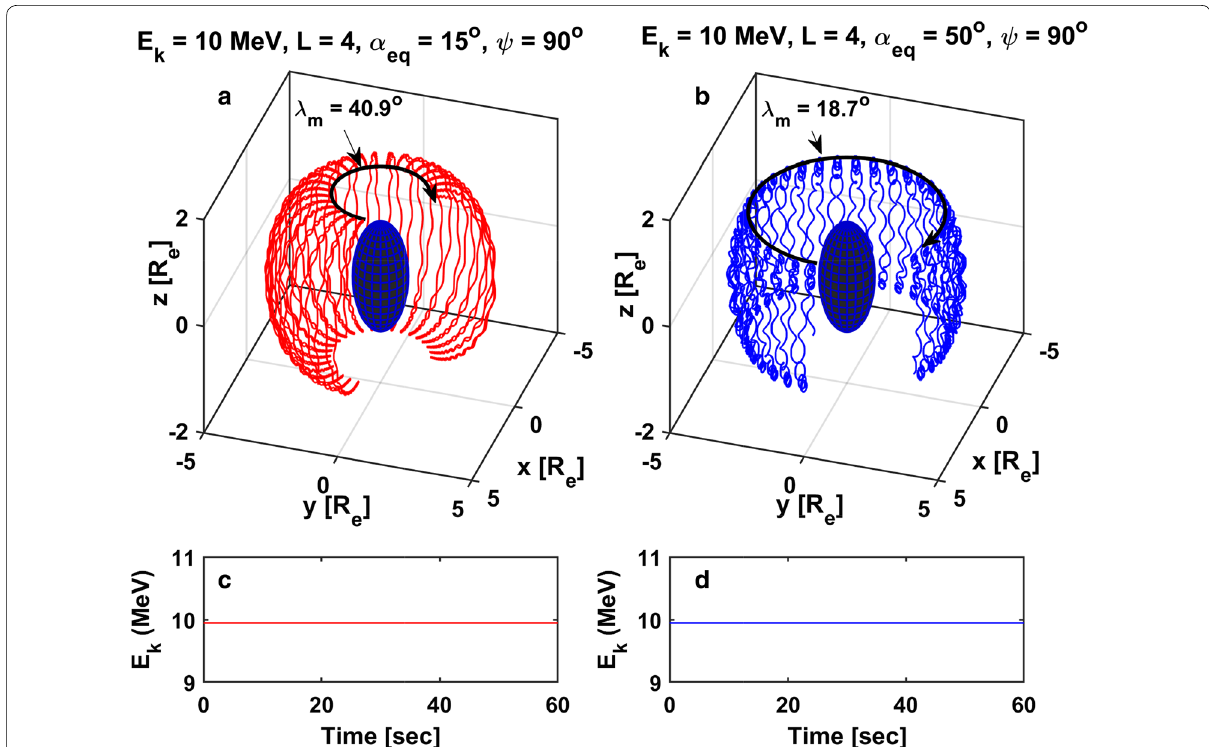
Fig. 1 Simulated three-dimensional trajectories of proton of energy 10 MeV and L = 4 (i.e., x = L − r L ) with equatorial pitch angle a α eq = 15 ◦ and b 50 ◦ in the Earth’s dipolar magnetic field for 60 s. The dipole moment is in the negative z-direction. The black arrow shows the westward motion of the proton due to ∇ B × B drift. The values of (cid:31) m for proton having α eq = 15 ◦ and α eq = 50 ◦ are 40.9 ◦ and 18.6 ◦ , respectively. The corresponding energy ( E k ) as a function of time is shown in c and d . Conservation of energy with time demonstrates the stability of the numerical